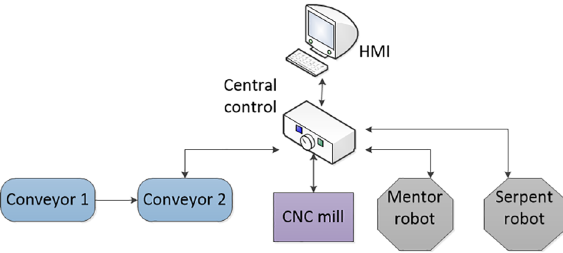
Fig. 5. The general control hierarchy of the manufacturing system (As-Is).